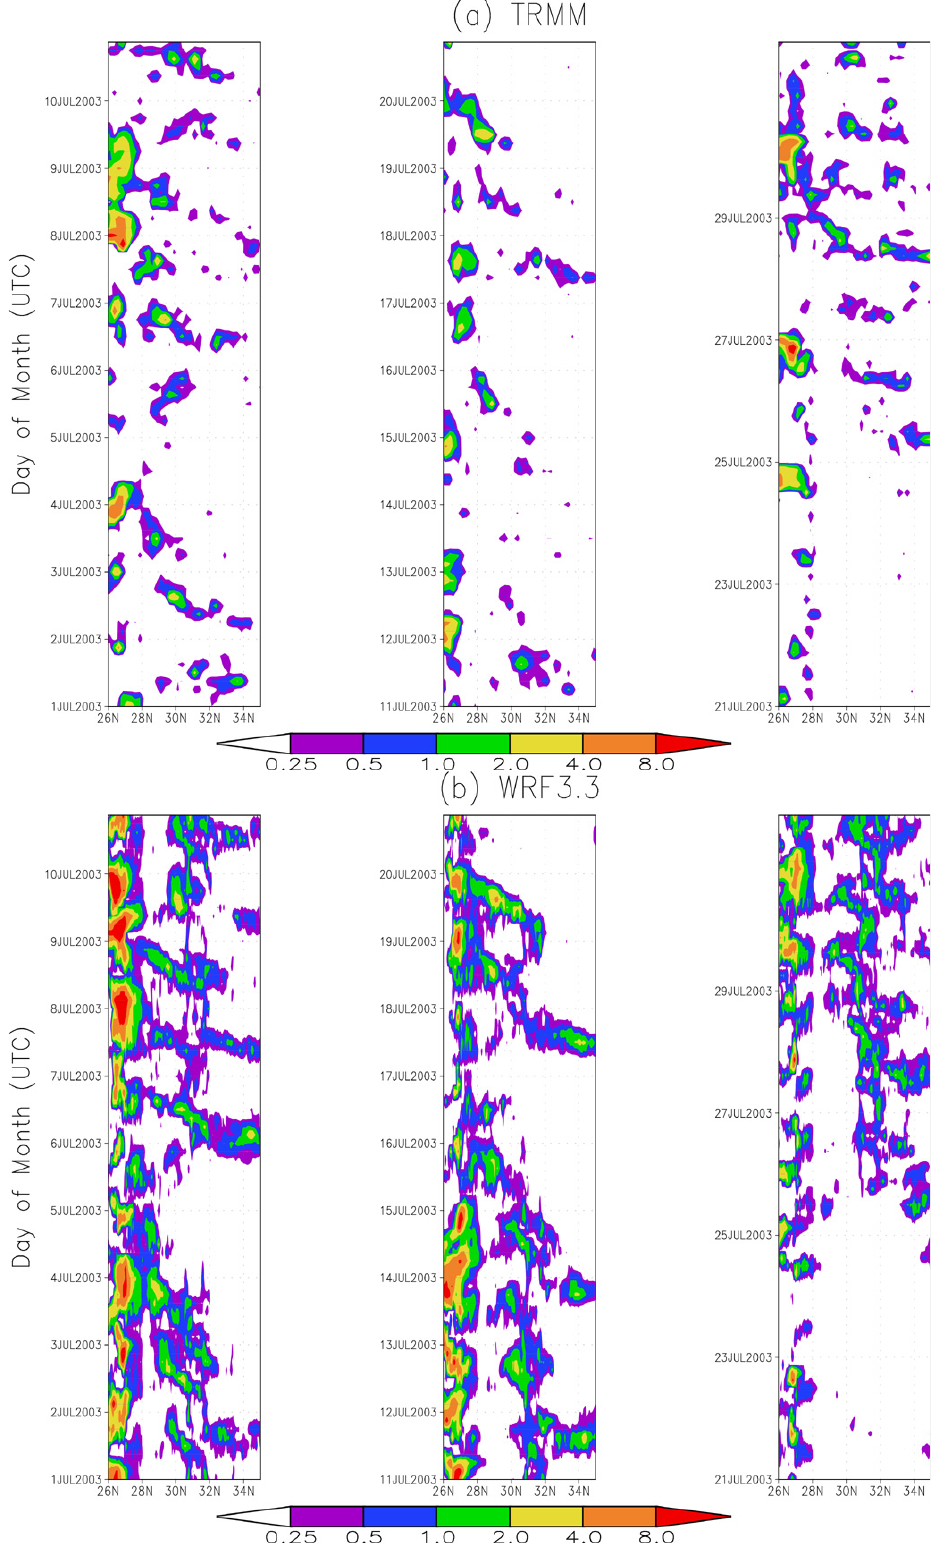
Fig. 11. The rain-rate (mmh − 1 ) Hovmoller time-latitudinal diagram averaged from 88 ◦ to 92 ◦ E for July 2003: (a) TRMM data, (b) model